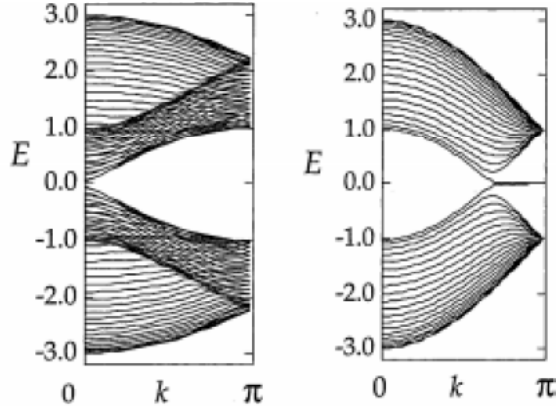
Fig. 3. Zone structure in the graphene nanoribbons for the : (a) chair structure and (b) zig-zag structure with N =20, adapted from